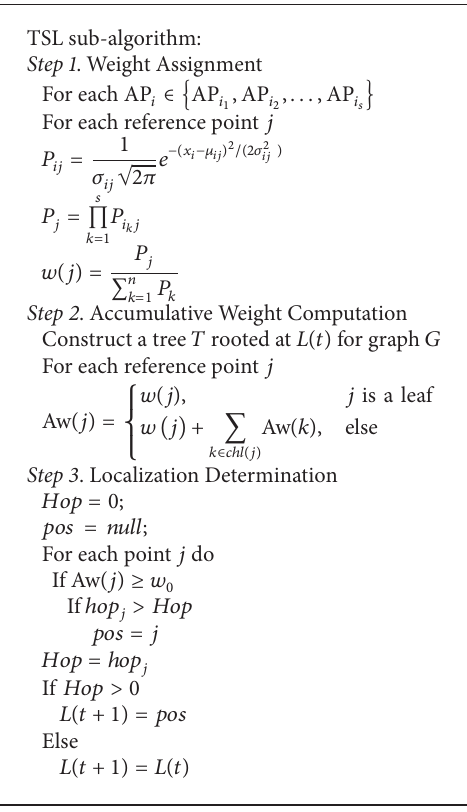
Algorithm 1: Formal description of the TSL